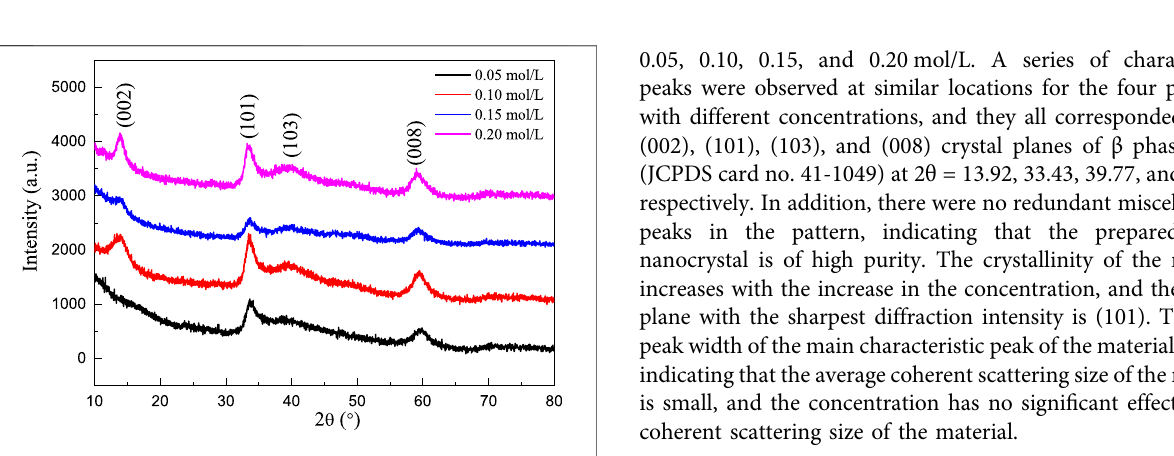
Frontiers in Materials |